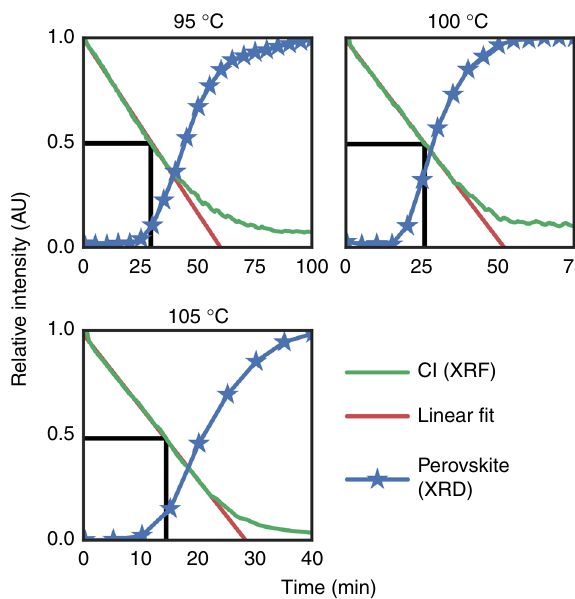
Fig. 4 Relative amount of Cl (from XRF) and crystalline perovskite (from XRD) while annealing at 95, 100, and 105 °C. Red line is a fi t to the linear regime of the XRF, demonstrating the zero-order kinetics of Cl evolution Black lines depict time when half of the Cl has evolved from the fi